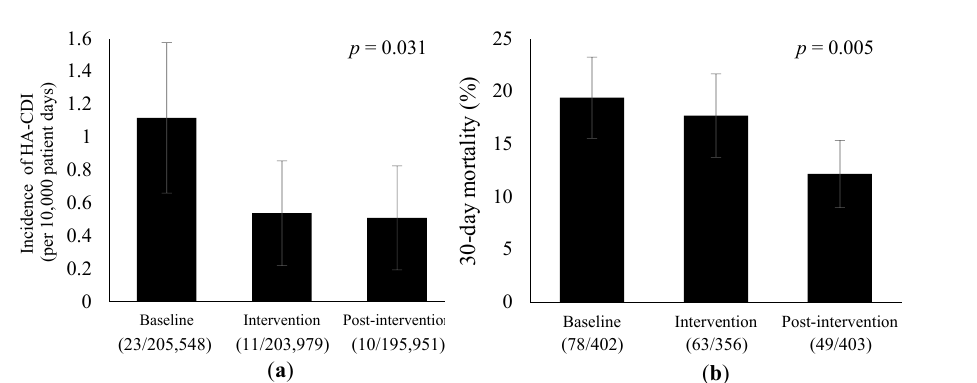
Table 7. Proportion of MRSA among all isolates of Staphylococcus aureus . tality showed a significant reduction from 19% at the baseline period to 12% during the Baseline Intervention Post-Intervention p acteristics of the patients with bacteremia. No significant differences were observed among the three periods. MRSA, n (%) 111/179 (62) 132/217 (61) 167/290 (58) 0.32 MRSA, methicillin-resistant Staphylococcus aureus .